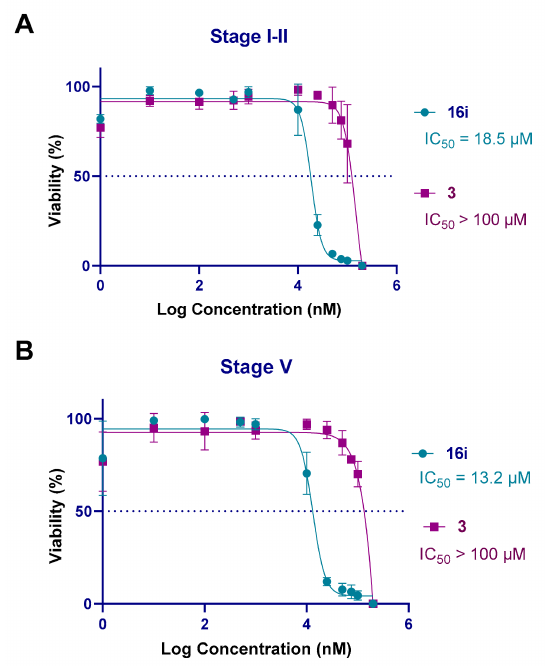
Figure 7. Inhibitory plots and IC 50 values of DXM 3 (purple) and cpd. 16i (cyan) against P. falciparum early (stages I–II) ( A ) and late (stage V) ( B ) gametocytes in vitro. IC 50 values are the mean of three technical replicates and three biological replicates. Error bars represent standard